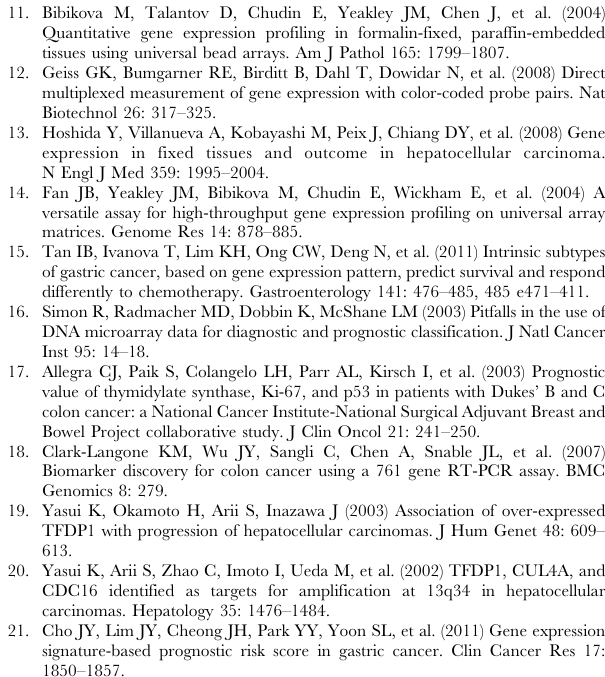
expressed between HER2-positive and HER2- negative patient groups in Step 1. d. Table S4 . List of all probes with univariate p- values , 0.01 in Step 1. e. Figure S2 . Gradient Lasso algorithm. f. Table S5 . List of 26 probes included in the prediction model fitted by the whole data set (n= 432). g. Table S6 . Multivariate Cox regression analysis results in gene discovery set (n= 432). 4. Design of focused gene expression assay using nCounter platform. a. Table S7 . List of reference genes for nCounter assay. b. Figure S3 . Correlation between hazard ratios of prognostic genes based on quantile normalization and self-normalization using WG-DASL assay. 5. nCounter assay and quality control. 6. Selection of cut-off for Gastric Cancer Prognostic Score (GCPS( Figure S4, S5, & S6 ). a. Figure S4 . DFS according to each quartiles of GCPS-g1. b. Figure S5. Cut-point analysis for GCPS-g1. c. Figure S6 . DFS according to optimized cut-point of GCPS-g1. 6. Distribution of GCPS between discovery set and validation set. a. Figure S7 . Distribution of GCPS-g1 within the discovery and validation set. b. Figure S8 . GCPS: intestinal vs diffuse type. 7. Testing of clinical utility of GCPS-g2 in patients